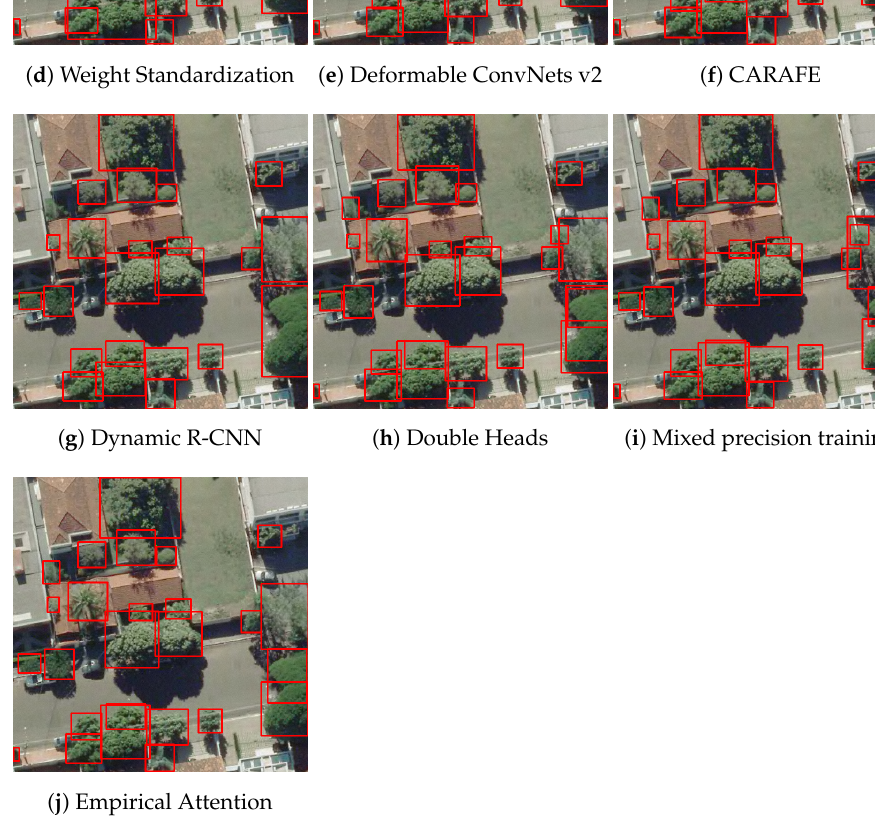
Figure 7. Examples of tree detection using the two-stage